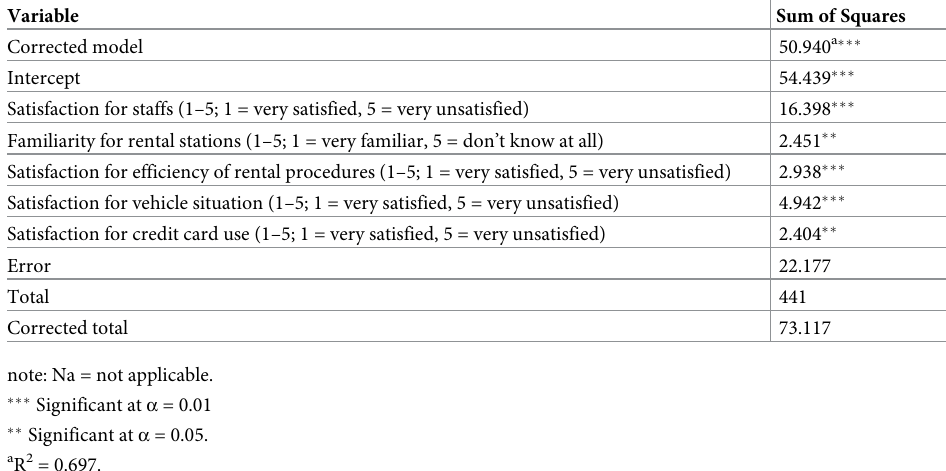
Table 2. Results of ANOVA on user